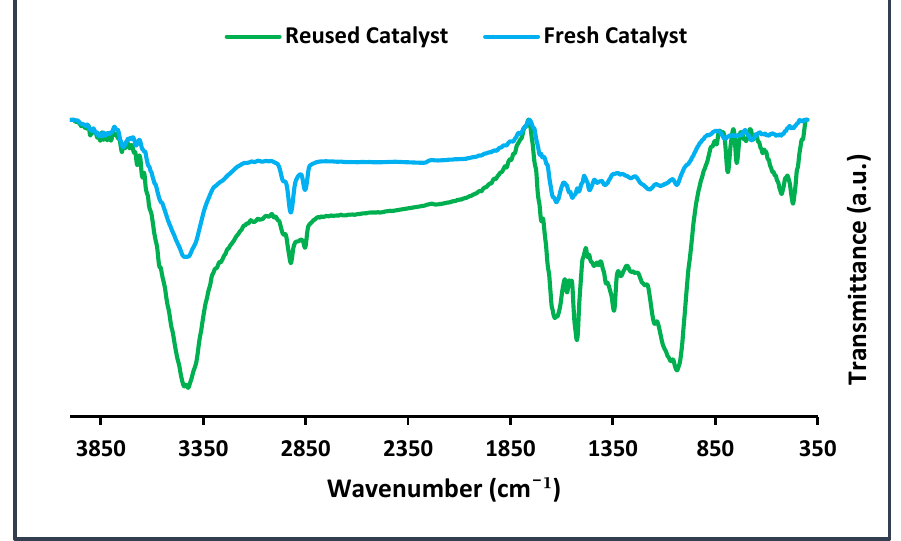
Figure 8. FTIR spectra of the recycled and fresh BC@GCN-P-IL after seven runs of the Biginelli reaction.